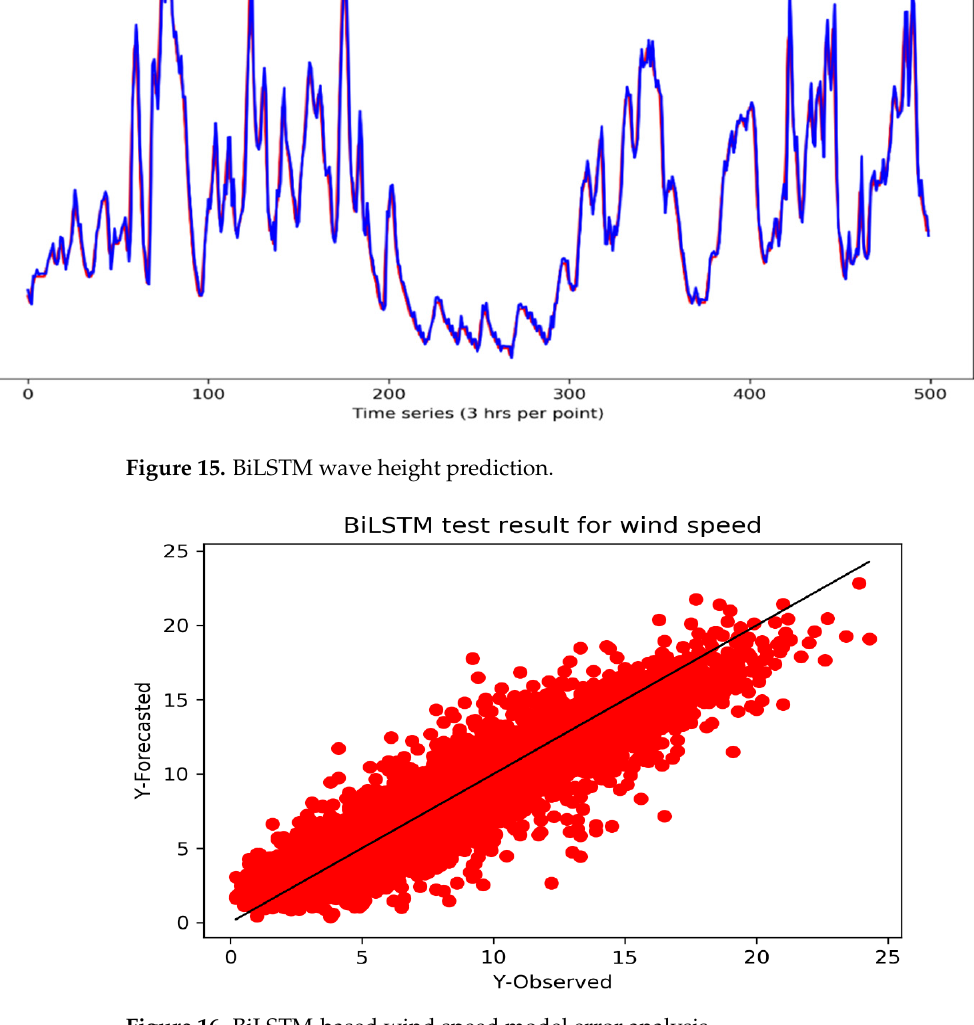
Figure 14. BiLSTM wind speed prediction.